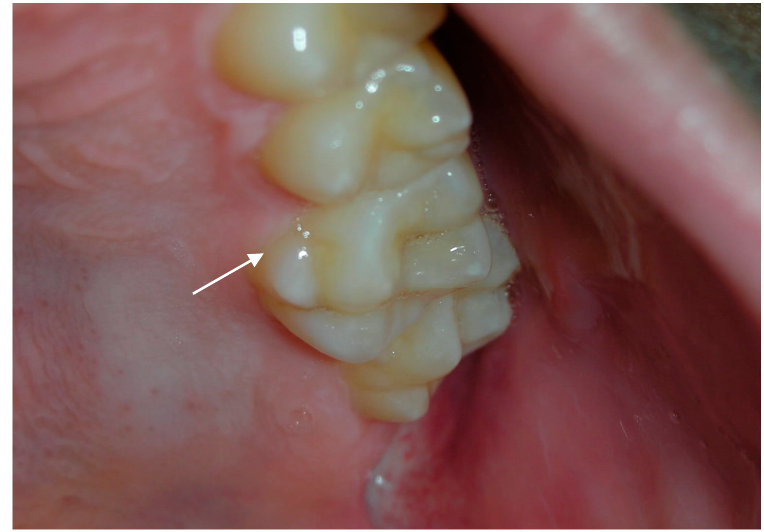
Figure 1. Accessory cusp, depicted by white arrow, found in a child affected by